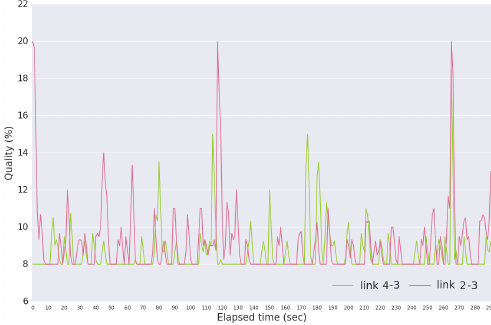
Figure 20. Quality values given by Equation (2) for link 4–3 and link 2–3 in Scenario B, test